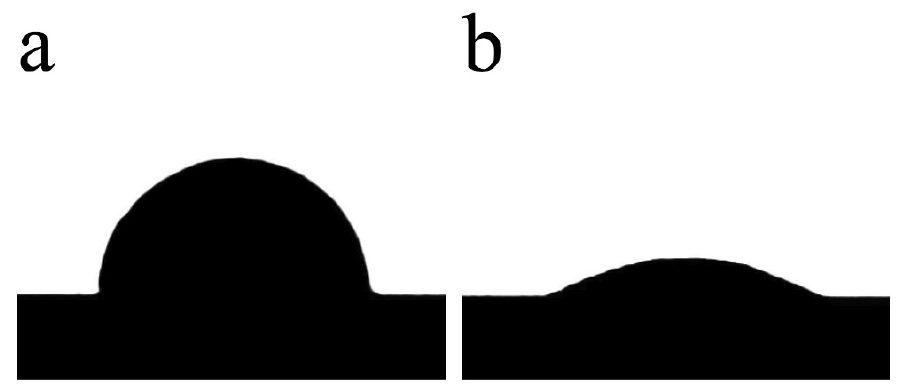
at 700 ◦ Figure 5. Wetting behavior of molten Al on two samples. ( a ) without film at 1000 °C; ( b ) with Al film at 700 °C.